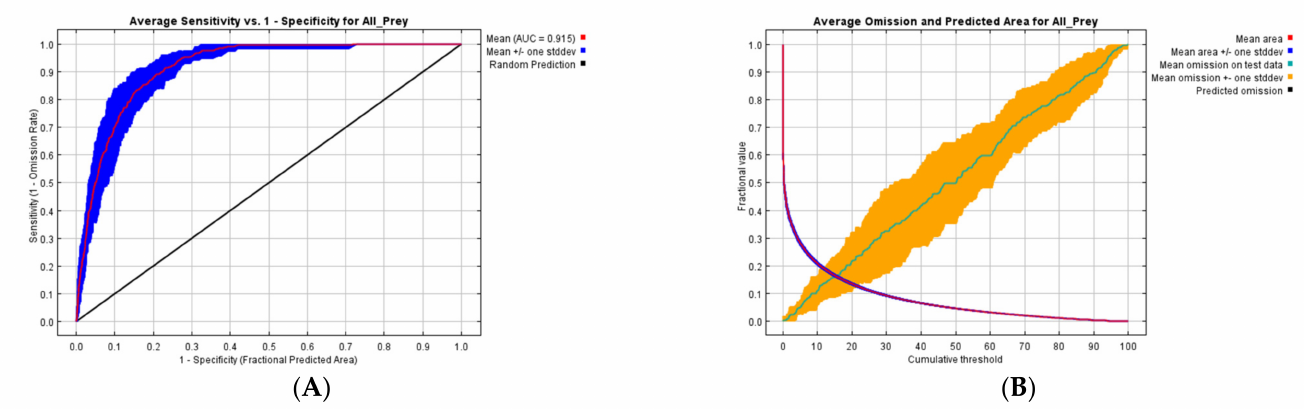
Figure A2. ( A ) Receiver operating characteristic (ROC) curve averaged over the ten replicate runs. The average test AUC for the replicate runs is 0.915, and the standard deviation is 0.0022. ( B ) The test omission rate and predicted area as a function of the cumulative threshold, averaged over the replicate runs.